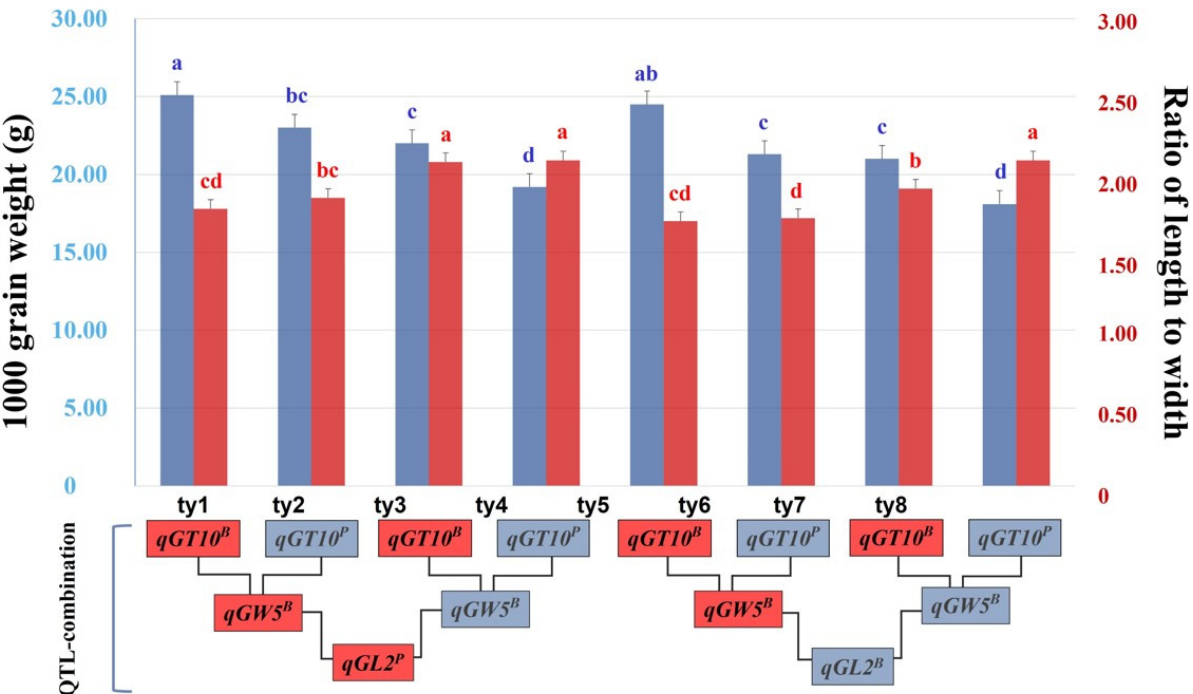
Figure 4. The phenotypic effect of the RLW and TGW by the QTL combination identified in this study. The blue bars and letters on the bar graph indicate grades involved in TWG, and red bars indicate grades involved in RLW. The red boxes of the QTL combination composed of eight groups (ty1–ty8) indicate positive QTL associated with the trait, and the gray boxes indicate negative QTL. The lower ‐ case letters on the error bar indicate significantly different values of measured traits based on the Duncan multiple range test (DMRT) at a 5% significance level. Meanwhile, the scatter plot showed the distribution of the trend of individual lines based on the type of QTL combination (ty1–ty8) for RLW and TGW (Figure 5). RLW was negatively and strongly correlated with TGW in selected lines ( r = − 0.57, p < 0.001). Among lines with a mean TGW of the P1 (Boramchan) level, only three lines in the ty3 group ( qGL2 P + GW5 B + qGT10 B ) showed a mean RLW of the P2 (Pecos) level.